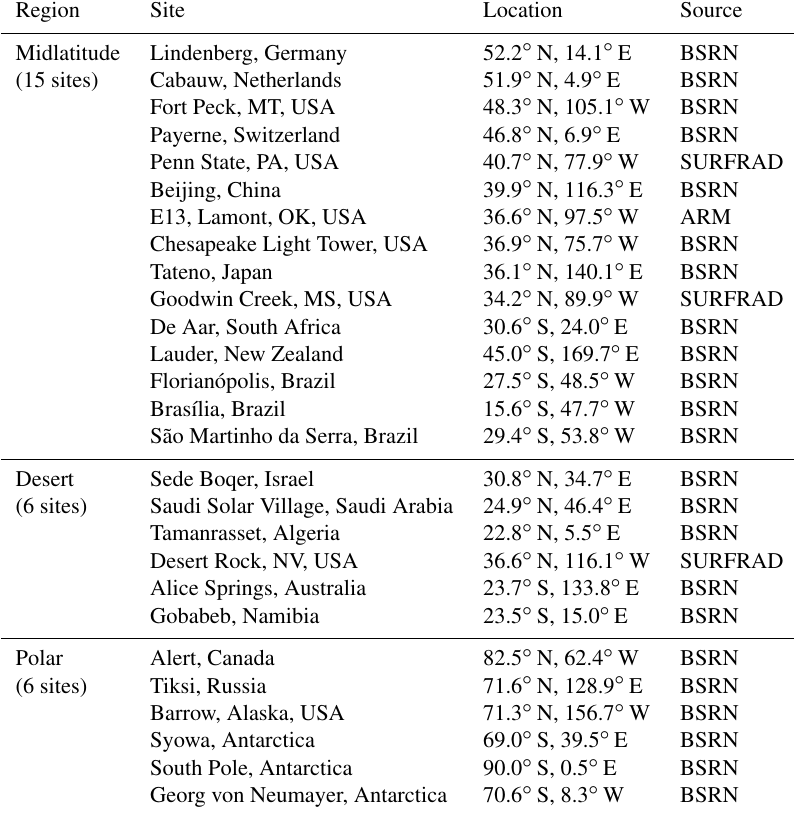
The abbreviations used in the table are as follows: BSRN – Baseline Surface Radiation Network (http://bsrn.awi.de/, last access: 1 August 2022); SURFRAD – NOAA SURFace RADiation